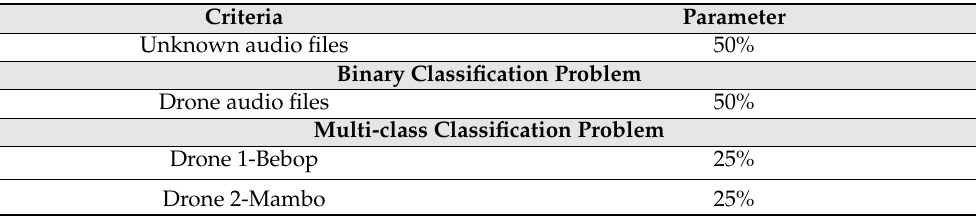
Table 8. Details on Data Distribution [38].